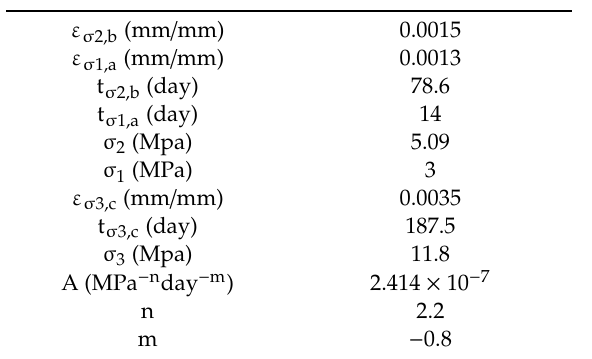
Table 1. Experimental results and the computed parameters of Norton-Bailey power law